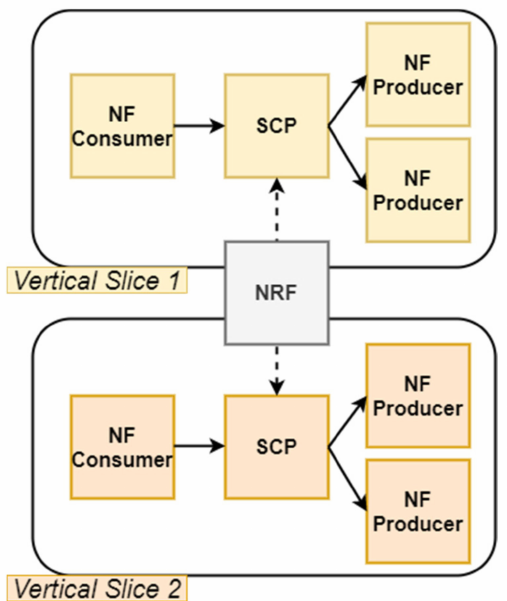
Figure 10. Trust domain for isolated slices within 5G Service-Based